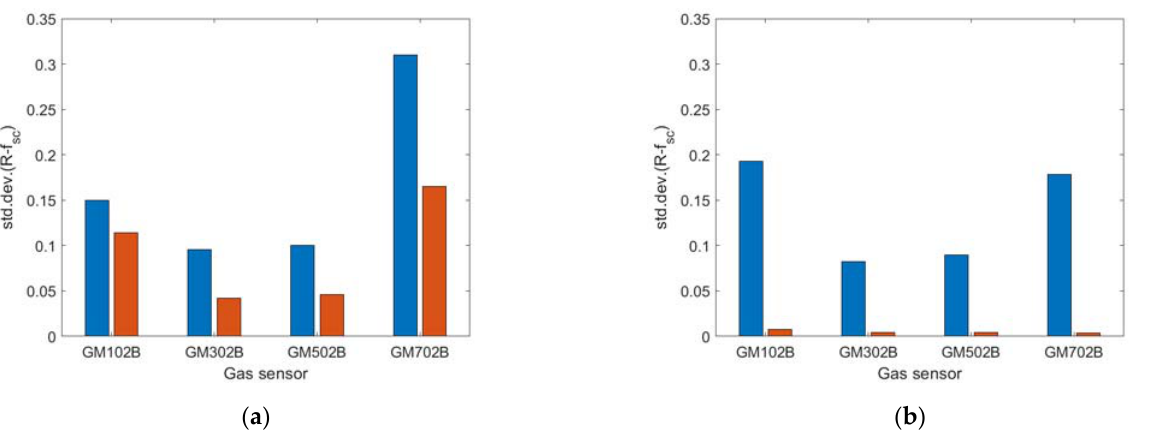
Figure 18. The magnitude of sensor signals variation due to exposure to air pollution when the sensing platform was lowered to the measurement point (blue bar) and when it was docked under the drone (red bar) during measurement, based on experiments: ( a ) CE1 (branches burning), and ( b ) CE2 (touchwood burning).